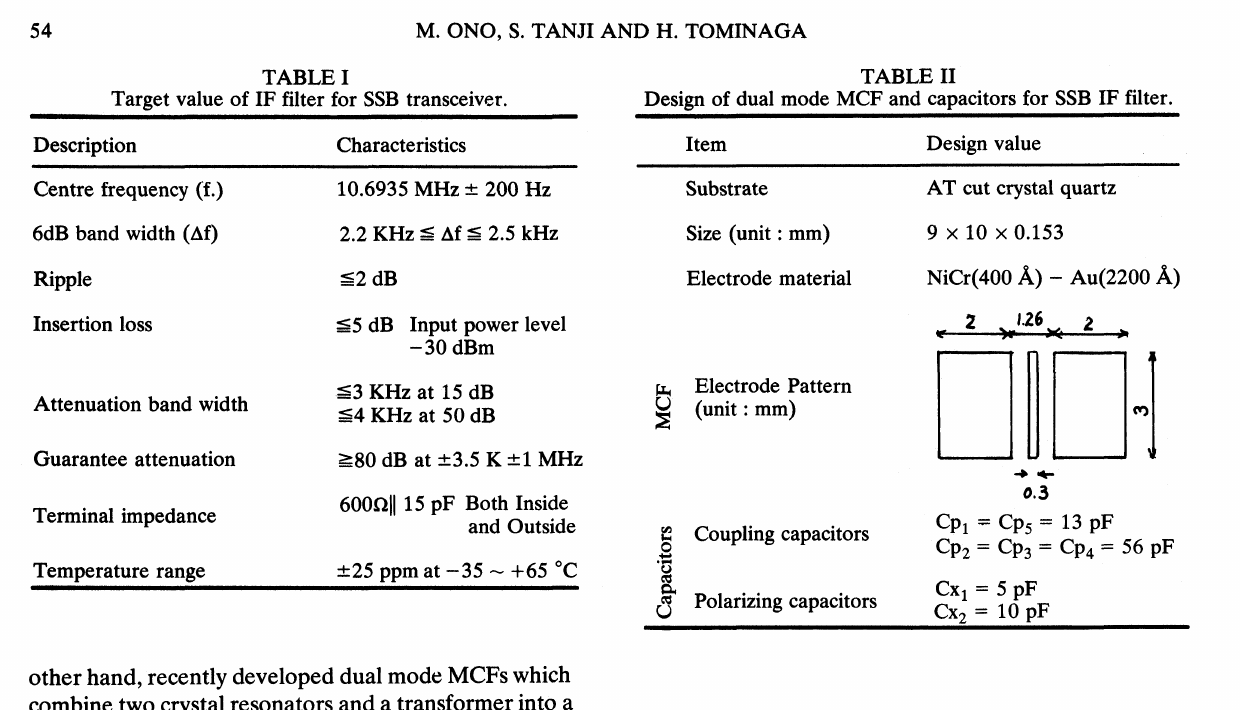
TABLE II Design of dual mode MCF and capacitors for SSB IF filter.